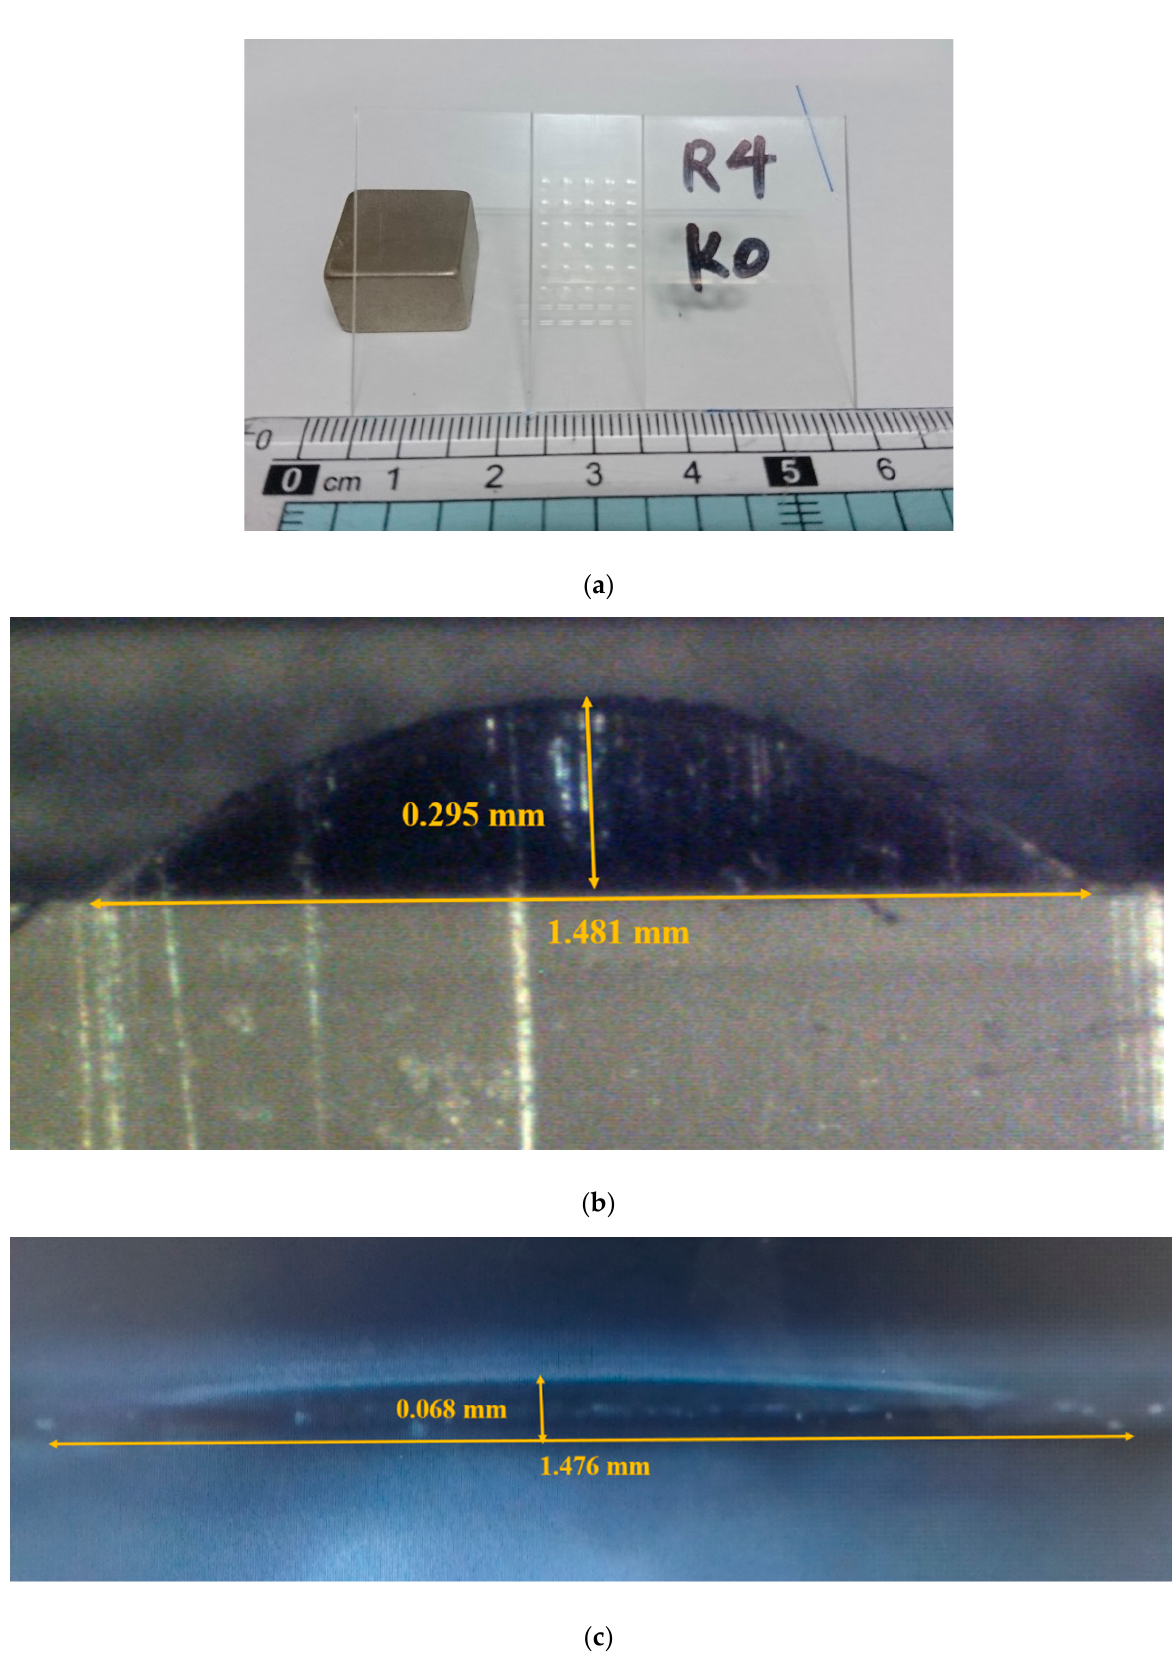
Figure 7. Microlens array fabrication results, ( a ) the array of 5 × 6 micro spherical lenses, ( b ) cross section of the fabricated microlens with R = 1 mm and ( c ) cross section of the fabricated microlens with R = 4 mm.